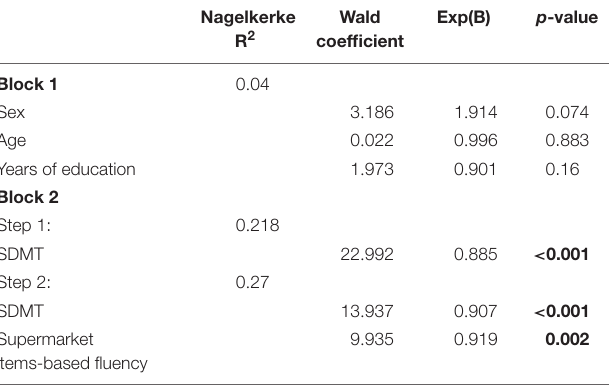
TABLE 5 | Logistic regression model determining the cognitive differences between the EwMS and